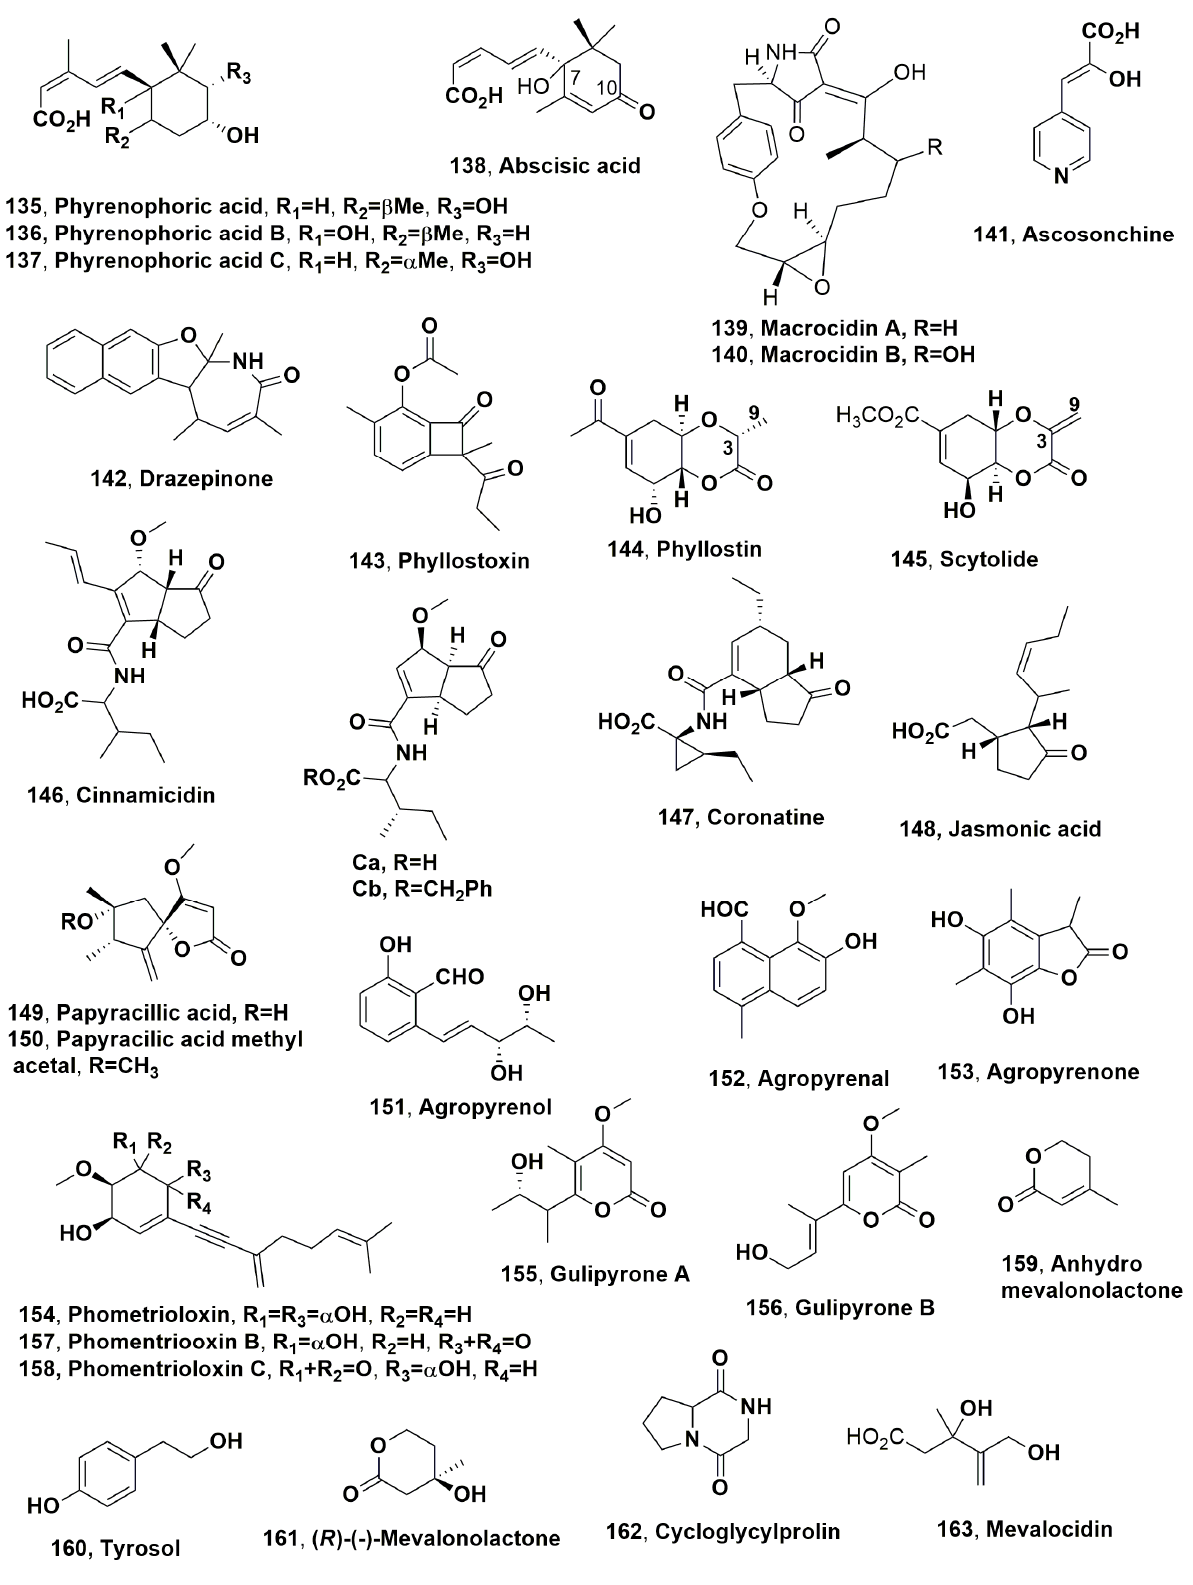
Figure 6. Metabolites produced Pyrenophora semeniperda ( 135 – 138 ), Phoma macrostoma ( 139 and 140 ), Ascochyta sonchi ( 141 ) Drechslera siccans ( 142 ), Phyllosticta cirsii ( 143 and 144 ), Scytalidium uredinicola ( 145 ), Nectria sp. ( 146 ), Pseudomonas syringae ( 147 ), Ascochyta agropyrina var. nana ( 149–153 ), Phomopsis sp. ( 154 ), Diaporthe gulyae ( 155–158 ), Alternaria euphorbiicola ( 159–162 ) and Coniolariella sp. ( 163 ).